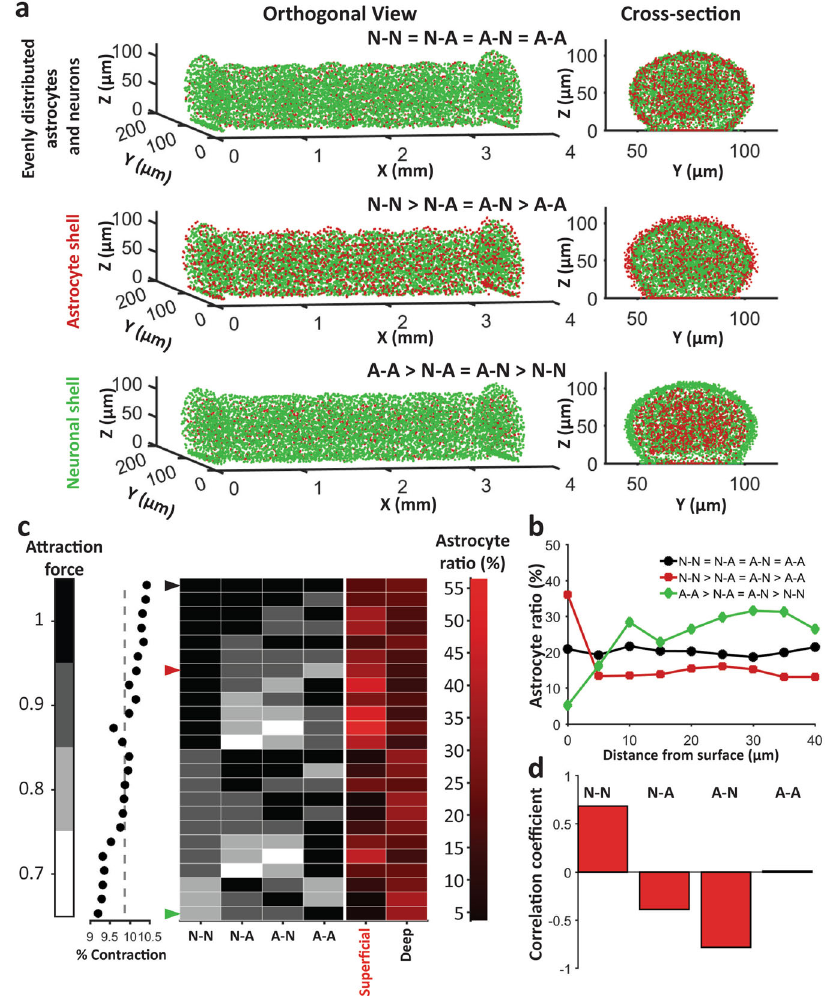
Fig. 7 Simulated outcome of different attraction force con fi gurations. a Orthogonal view (left) and cross section view (right) of three sample con fi gurations: top: N-N = N-A = A-N = A-A con fi guration yielded uniformly distributed neurons and astrocytes, middle: N-N > N-A = A-N > A-A yielded astrocyte shell, bottom: A-A > A-N > N-A > N-N yielded neuronal shell. b Mean astrocyte to total cell ratio at different distance from surface for the three con fi gurations in a . c % contraction (left, dot plot), Astrocyte ratio (right: shades of red) at surface and maximum astrocyte ratio in deep layers (more than 10 μ m below surface) for different relative cell attraction constants (indicated by shades of black). Arrows indicate the cases shown in a and b . d Correlation coef fi cients between values of different adhesive forces and astrocyte ratio in the super fi cial on cell aggregation and sorting in silico. Relative force order of N- N > N-A = A-N > A-A resulted in an astrocyte shell (Fig. 7a, middle, Fig. 7b, red trace), while force order of A-A > A-N = N- A > N-N resulted in an astrocyte-void neuronal shell (Fig. 7a, bottom, Fig. 7b, green trace). Keeping all the forces equal resulted in a uniform distribution of astrocytes (Fig. 7a, top, Fig. 7b, black trace). We then simulated 24 different force con fi gurations shown in Fig. 7c. All of these con fi gurations yielded equal number of clusters and similar contraction (within 1.5%, Fig. 7c, dot plot). The black arrow at the fi rst row indicates the case of equal relative forces which yields uniform astrocyte distribution (same case is shown in Fig. 7a top, and by black trace in Fig. 7b). Red arrow (seventh row) indicates N-N > N-A = A-N > A-A case shown in Fig. 7a middle, and described by red trace in Fig. 7b. Green arrow (last row) shows A-A > N-A = A-N > N-N case corresponding to Fig. 7a bottom, and green trace in Fig. 7b. We observed that the existence of the astrocytic shell was heavily dependent on the relative order of forces. To analyze the relation between these forces and astrocytic shell and center cluster formation, we cal- culated cross-correlation coef fi cient of each force (force column,